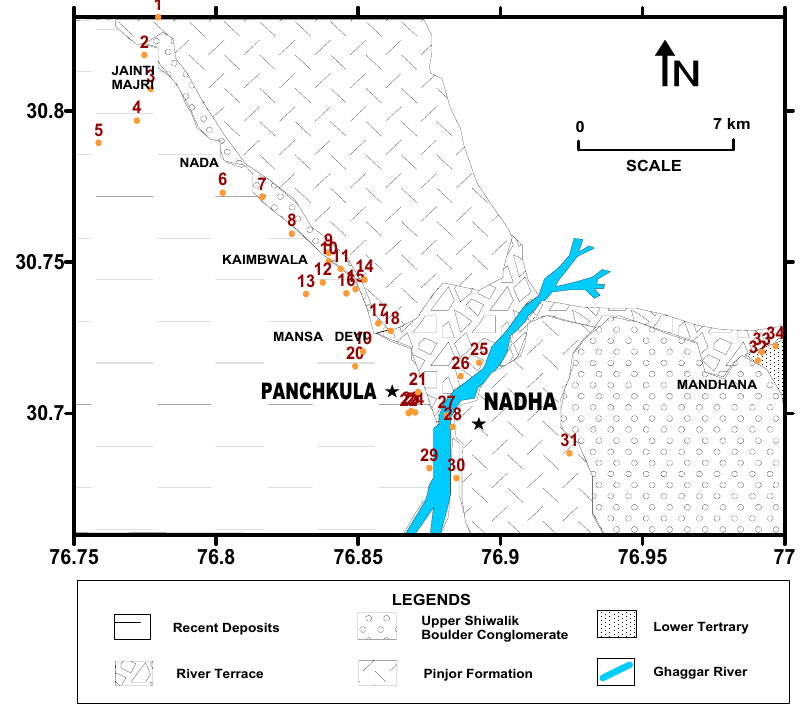
Fig.2: Map of Nadha and adjoining areas showing the geology of the study area and Fig. 2. Map of Nadha and adjoining areas showing the geology of the study area and locations of soil gas samples (marked 1–34) locations of soil gas samples (marked 1-34) collected.